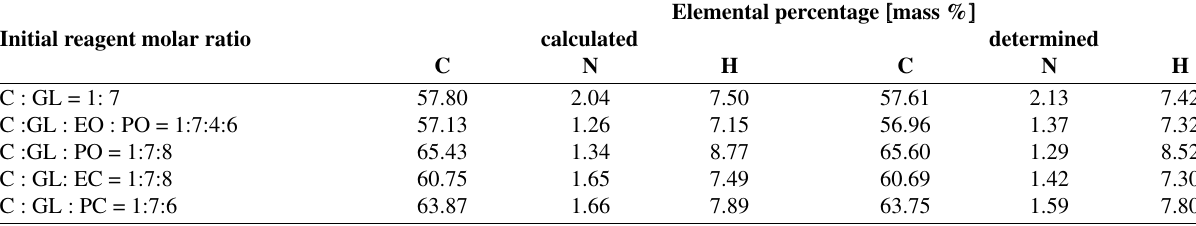
Table 3. Elemental analysis data of oligoetherols